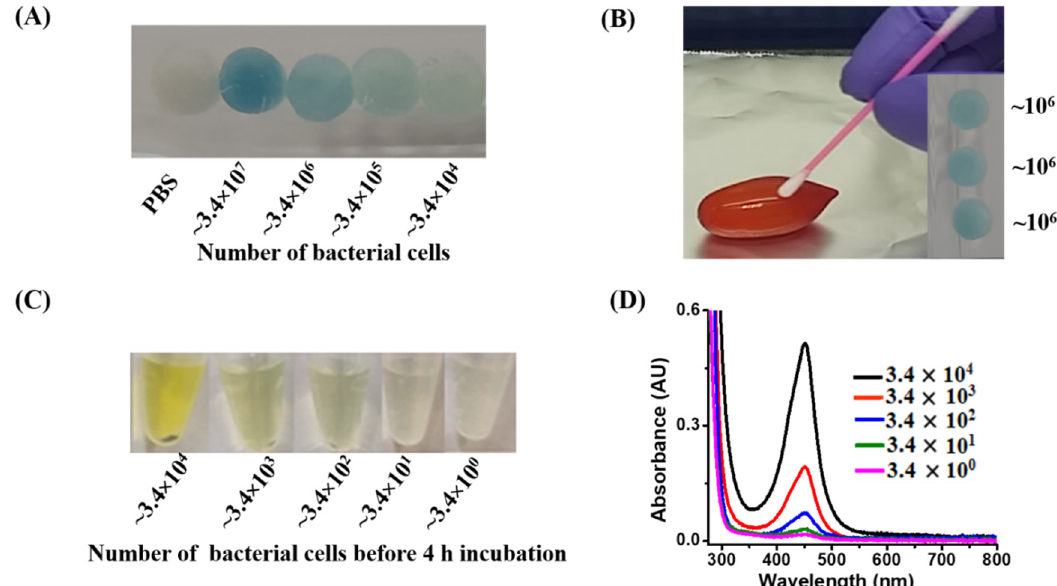
Figure 6. Detection of bacteria from bacterium-contaminated cherry tomatoes. ( A ) Photograph of the cotton swabs obtained after sampling bacteria from the cherry tomatoes smeared with PBS only, and ~3.4 × 10 7 –3.4 × 10 4 E. coli O157:H7 cells (left to right), followed by dipping into a reagent (50 µL) containing H 2 O 2 (~11.2 mM) and TMB (1.25 mM) at pH 3. ( B ) Photograph of the as-prepared tomato that was sampled by a cotton swab. The photograph inset on the right-hand side shows the three swabs obtained after sampling bacteria from the surface of three individual tomatoes smeared with ~10 6 cells of E. coli O157:H7, followed by immersion in a reagent droplet (50 µL) containing H 2 O 2 and TMB at pH 3. ( C ) Photograph of the samples obtained after collecting bacteria from the cherry tomatoes smeared with ~3.4 × 10 4 –~3 E. coli O157:H7 cells (left to right), followed by incubation in a growth broth (0.4 mL) for 4 h and then reacted with the reagent (0.2 mL) containing H 2 O 2 (~11.2 mM) and TMB (1.25 mM) at pH 3, and the addition of sulfuric acid (2 M, 2 µL). ( D ) The corresponding UV–Vis absorption spectra of the samples obtained in ( C ).